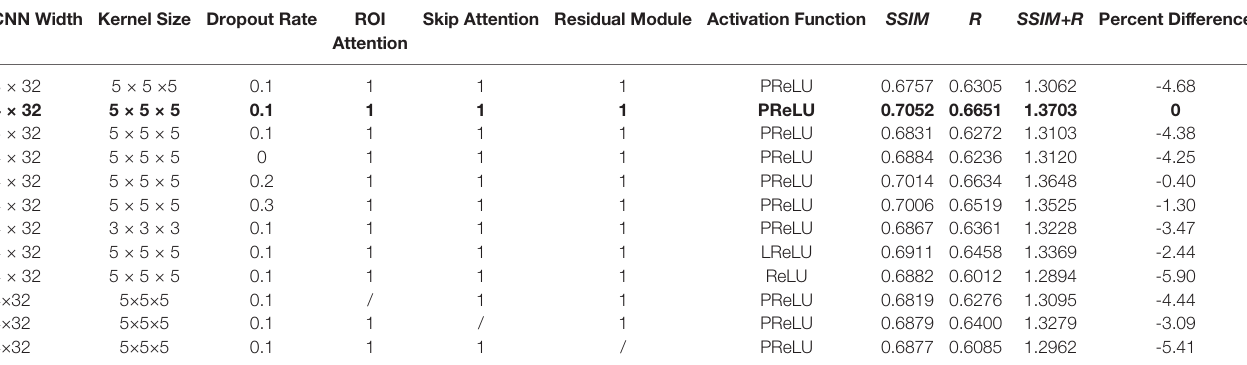
The bold values indicates the optimal con fi gurations.